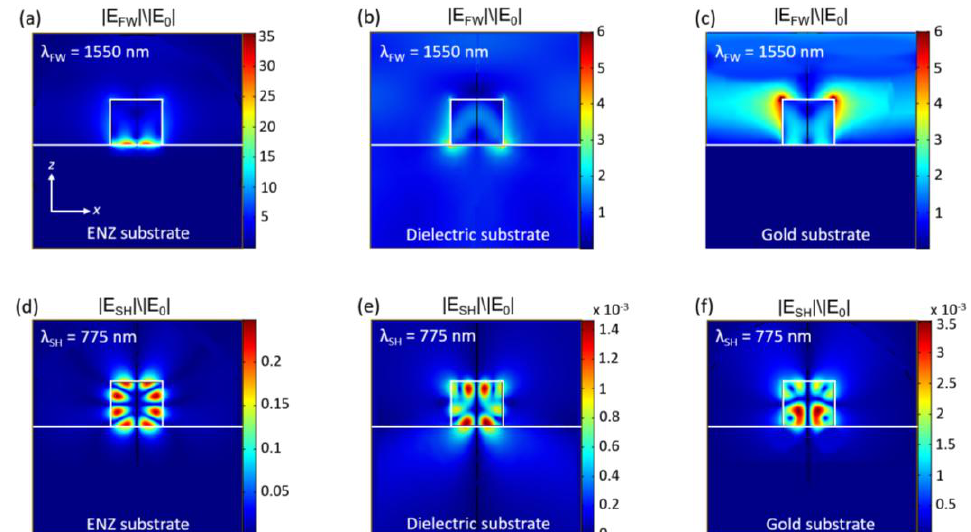
Figure 2. Electric field enhancement at the fundamental wavelength FW (second harmonic SH) in the case of nanocylinder of radius 232 nm, and height h equal to 400 nm placed over the ENZ (( a ) at FW and ( d ) at SH), the dielectric (( b ) at FW( e ) at SH) and the gold substrate (( c ) at FW and ( f ) at SH).